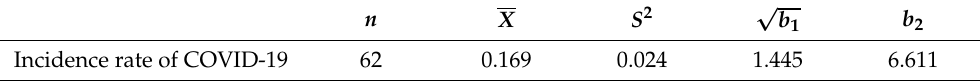
Table 6. Descriptive statistics for data in Application 2.